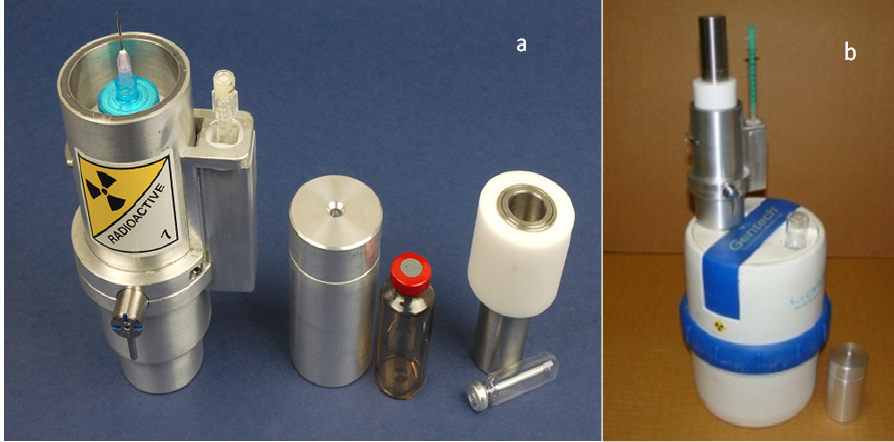
Figure 8. Radioisotope concentrator device ULTRALUTE ® [4] with its accessories ( a ) and in-line attachment of ULTRALUTE ® to Gentech 99m Tc-generator to perform an